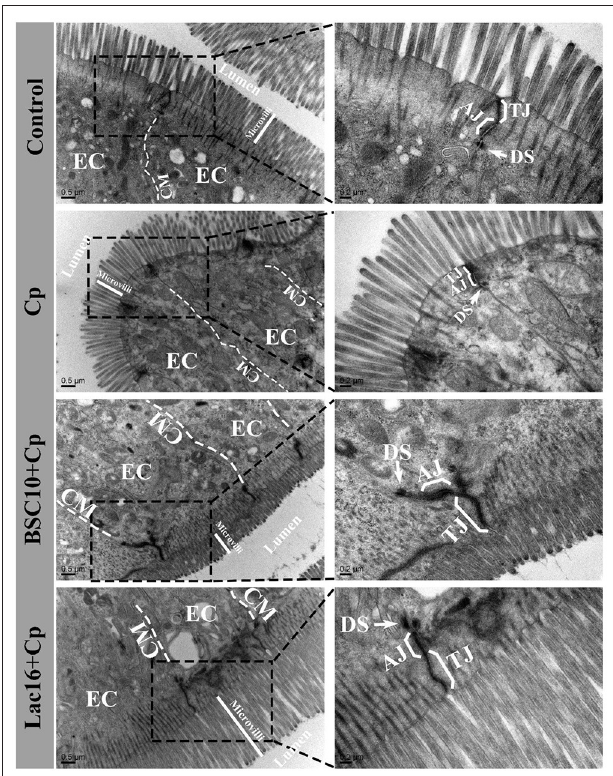
( Figure 2 ). Compared with the C. perfringens -infected group,